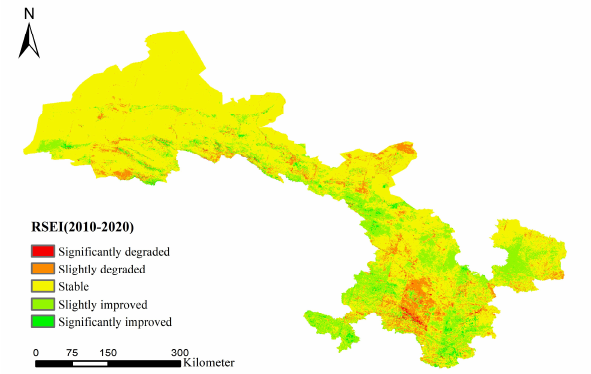
Figure 7 . Changes in ecological quality from 2010 to 2020.